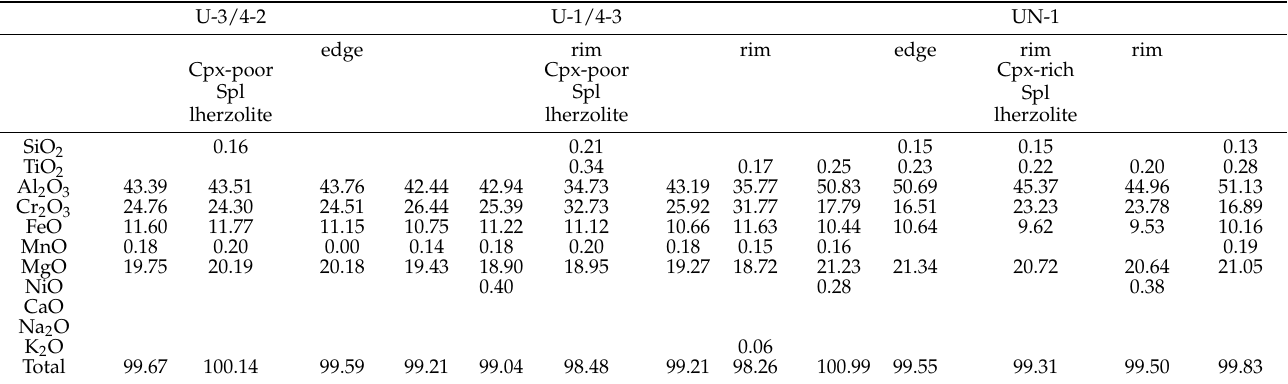
Table 1. Representative major oxide (wt%) and mineral compositions of spinel in lherzolite upper mantle xenoliths from Jetty